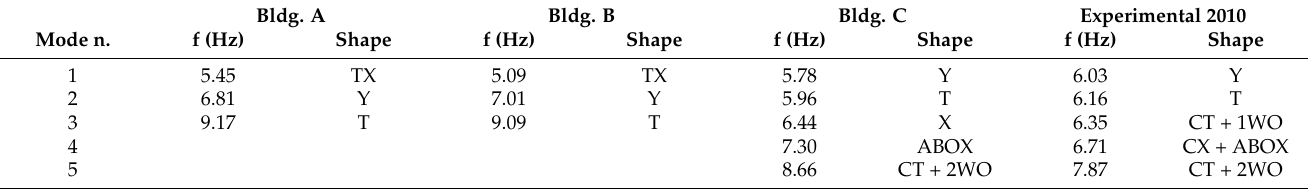
Table 3. Numerical natural frequencies (f) of the first 5 modes obtained by models of the three buildings (A, B and C) completely independently and comparison with the 2010 experimental values. For the description of modal shapes refer to the caption of Table 1, adding: TX = torsional + translation along X; X = translation along